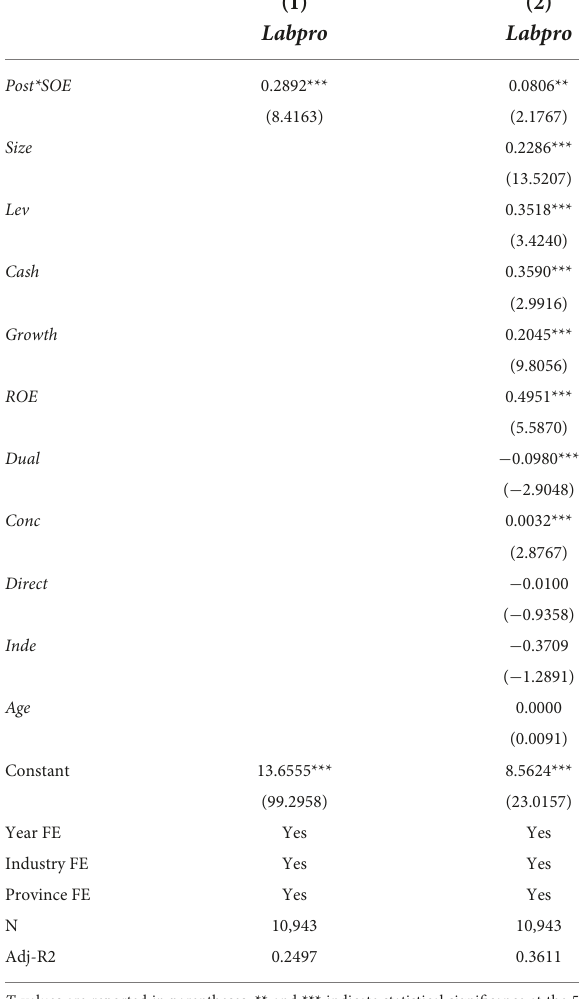
TABLE 3 Employee compensation controls and labor